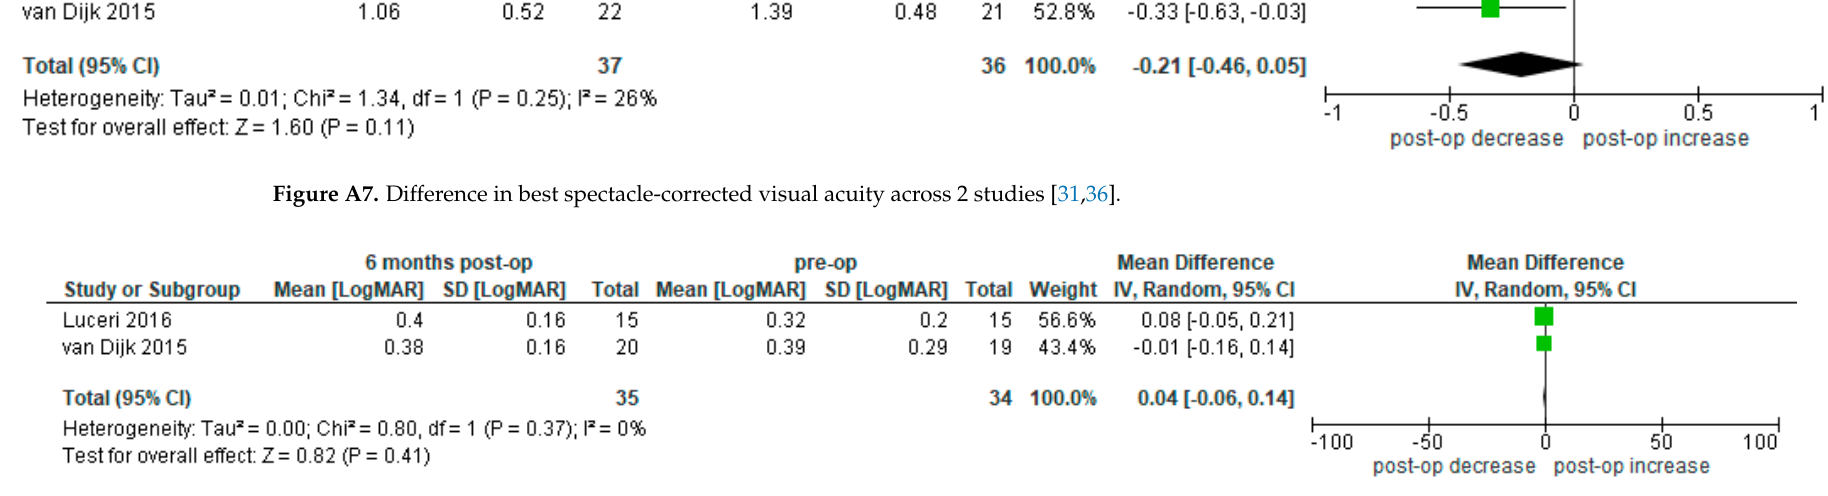
Figure A8. Di ff erence in best contact lens-corrected visual acuity across 2 studies [31,36].